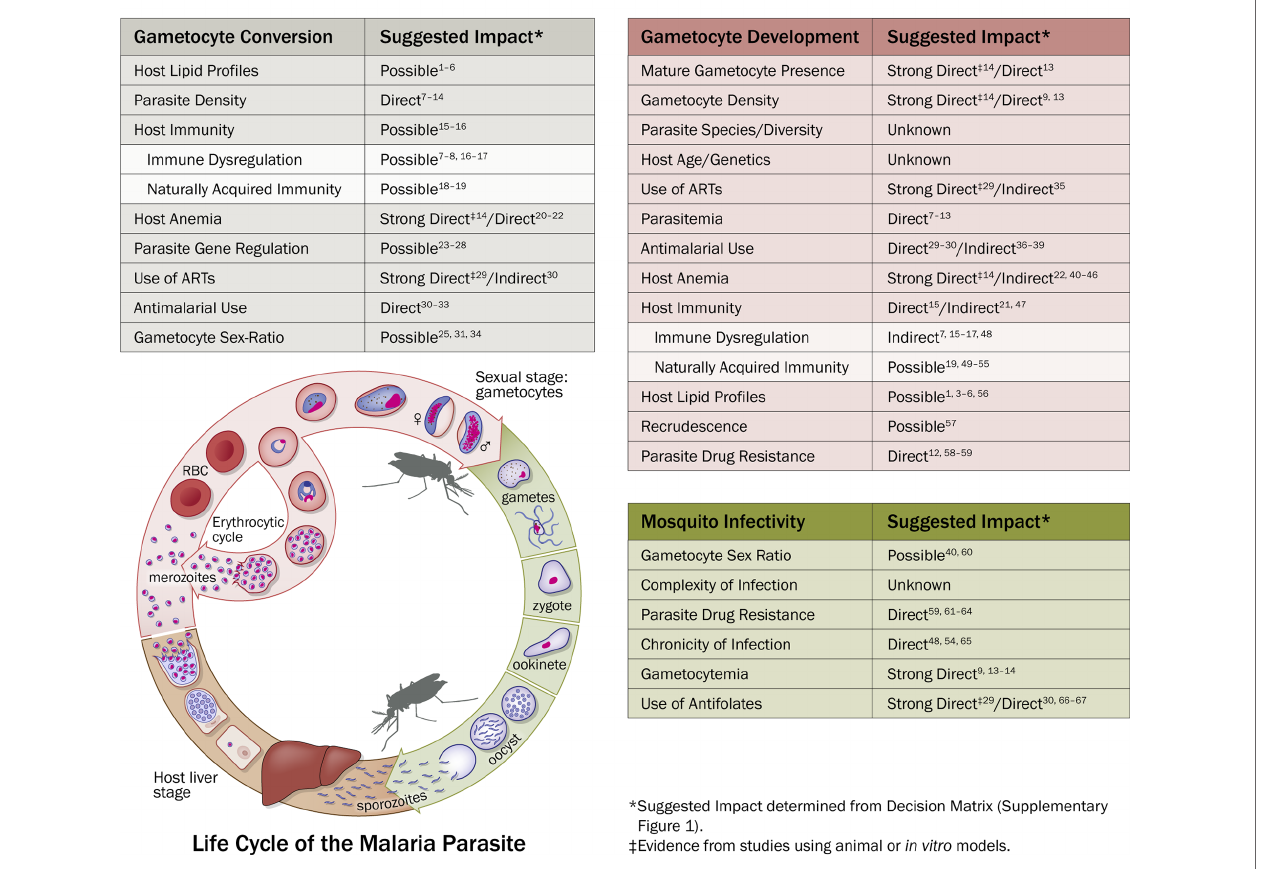
FIGURE 3 | Malaria Life Cycle and Selected Factors In fl uencing Malaria Parasite Transmission and Suggested Impact During HIV-1 Malaria Co-infection. Example of selected factors that are known to be associated with malaria parasite transmission and the suggested impact (determined using Decision Matrix, Supplementary Figure 1 .) with HIV-1 and/or malaria/HIV-1 co-infection. Suggestive impact is used due to the lack of available statistical evidence and the dif fi culty in ascertaining the biological relationship between malaria/HIV-1 co-infection and malaria parasite transmission success. Strong Direct Impact means that there is evidence, which includes mosquito transmission data, to suggest that HIV-1 malaria co-infection directly alters gametocyte conversion (GC), gametocyte development (GD), or mosquito infectivity (MI). Direct Impact means there is evidence, sans mosquito data, to suggest that HIV-1 malaria co-infection directly alters GC, GD, or MI. Indirect impact means there is evidence to suggest that HIV-1 or HIV-1 malaria co-infection indirectly alters factors that in fl uence GC, GD, or MI. Possible Impact means there is evidence to suggest that HIV-1 or HIV-1 malaria co-infection may alter factors associated with GC, GD, or MI. Unknown Impact means there is currently not enough evidence to suggest that HIV-1 or HIV-1 malaria co-infection directly or indirectly alter GC, GD, MI, or the factors associated with GC, GD, or MI. The left table (gray, “ Gametocyte Conversion ” ) represents selected transmission factors that pertain to the gametocytogenesis and gametocyte commitment. The center table (red, “ Gametocyte Development ” ) represents selected transmission factors that pertain to the sexual stage development. The right table (green, “ Mosquito Infectivity ” ) represents selected factors that may in fl uence infectivity to mosquitoes and subsequent mosquito transmission success. In the middle is a representation of the life cycle of Plasmodium falciparum (adapted from NIAID/NIH, 2016, https://www.niaid.nih.gov/diseases-conditions/malaria-parasite) representing the exo- erythrocytic (liver) cycle, erythrocytic cycle (bloodstream), and sexual stage (gametocyte) development in the host, and the sporogonic cycle in the